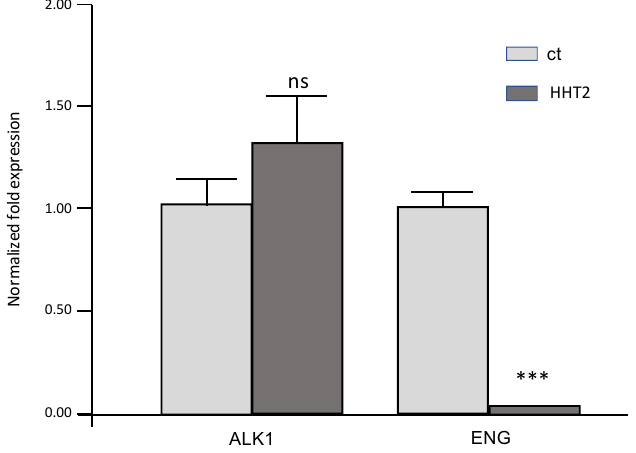
Figure 3. RT-qPCR of ALK1 in the HHT proband (HHT2) and unaffected relative (ct), showing the quantification of ALK1 RNA (ns: non-significant; *** p < 0.005).